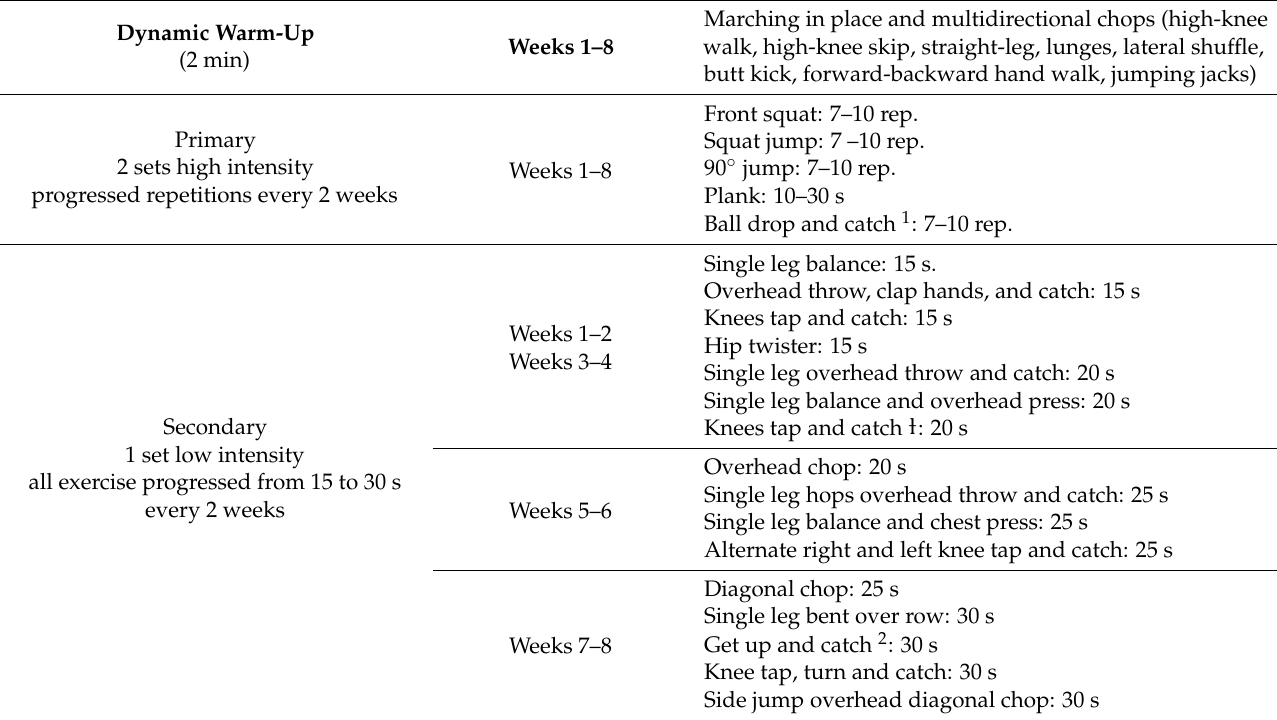
Table 2. Structure of the EG program.